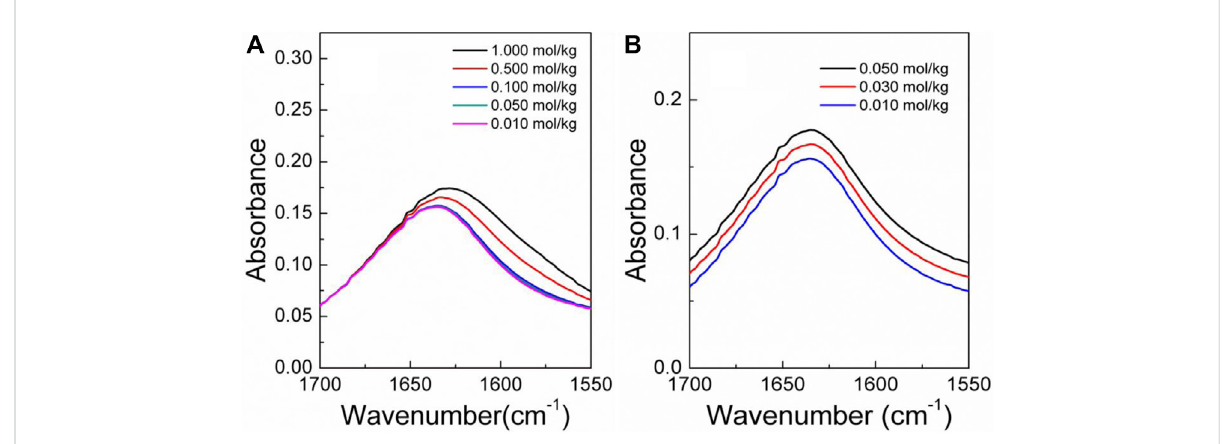
FIGURE 7 Infrared spectra of the DL -proline aqueous solution in the range of v (C=O). (A) Actual curve. (B) Elevated curve of (A) .